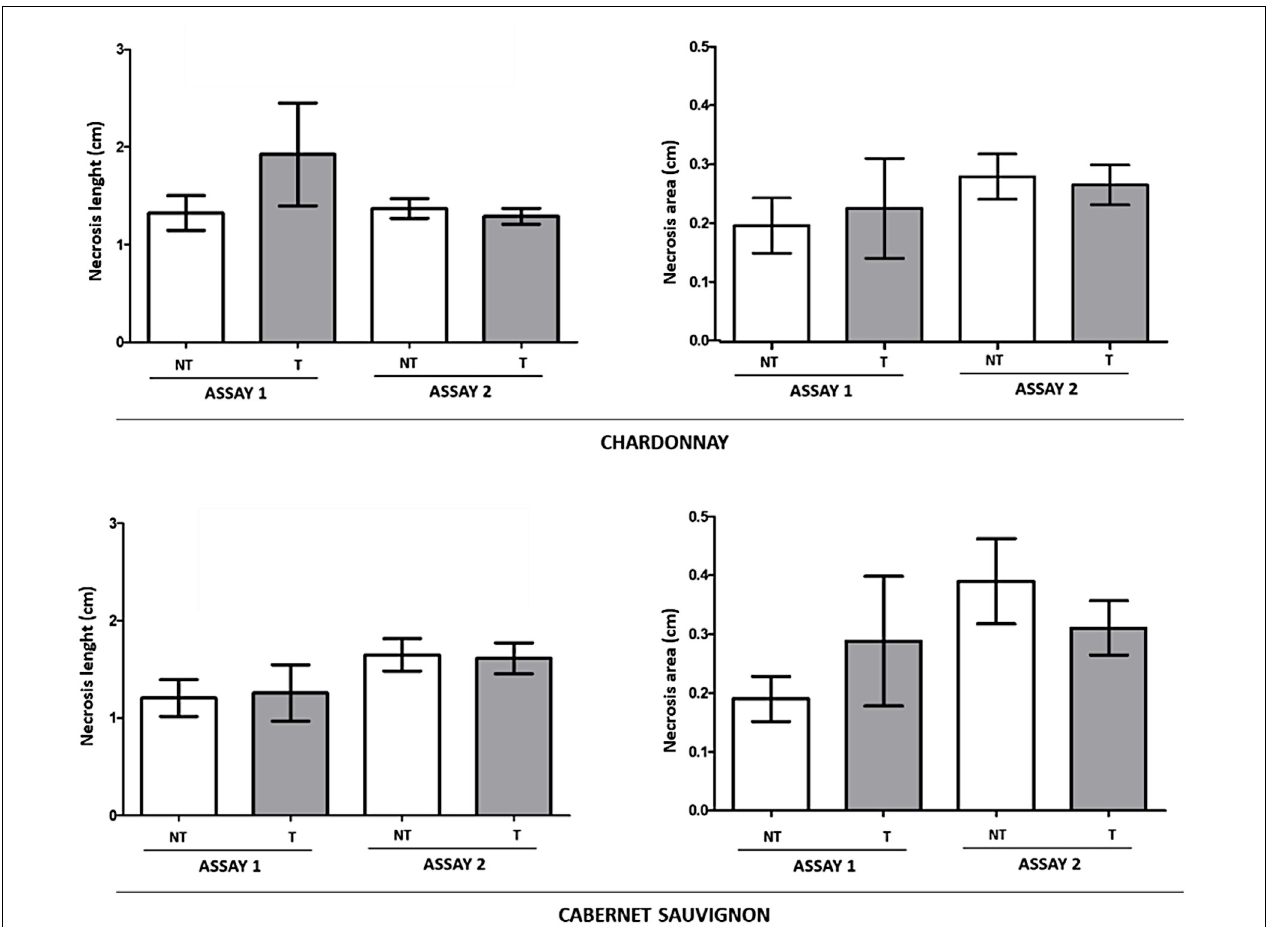
FIGURE 7 | Global effect of LC2017 treatments on internal necrosis length and area development recorded in Assay 1 and Assay 2 in rooted cuttings “Chardonnay” (upper part) and “Cabernet sauvignon” (lower part) when inoculated with the two Botryosphaeriaceae species D. seriata and N. parvum and recorded at 60 dpi (W2 in Figure 1